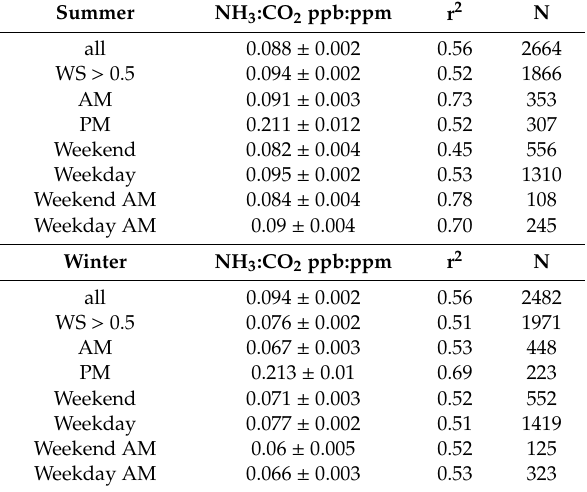
Table 8. The ratio of the measured NH 3 (ppbv) and CO 2 (ppmv) derived from the slope ( ± standard error of the estimate) and r 2 of the WODR regression. N is the number of points used in the regression.